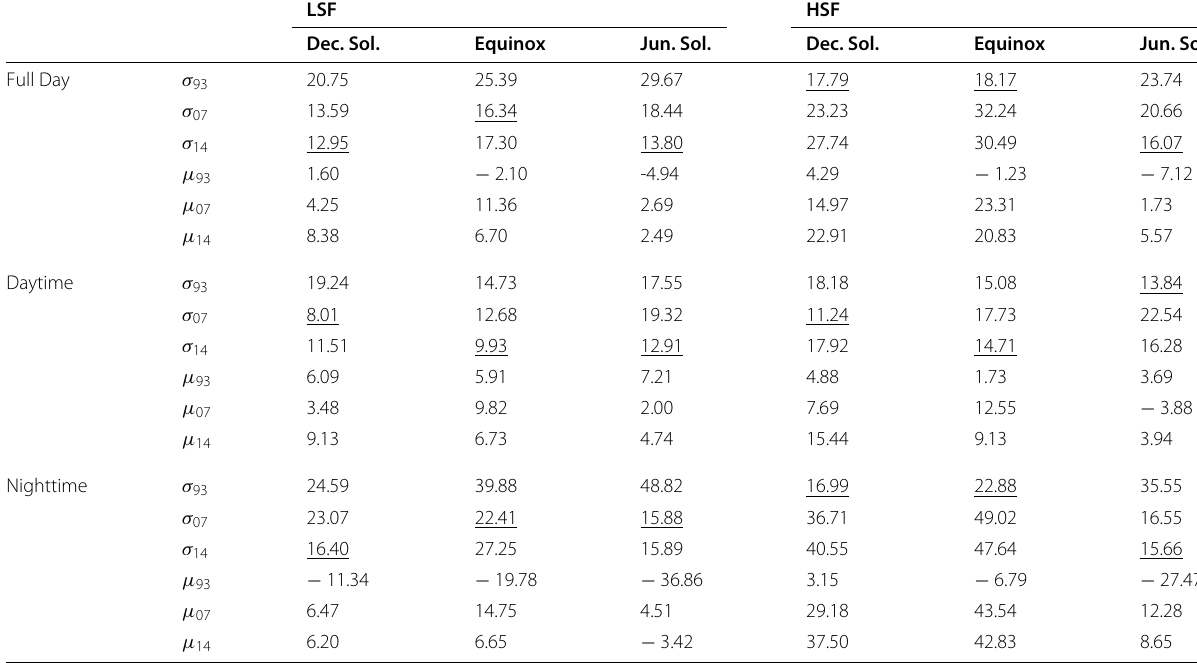
Table 1 The weighted root-mean-square error ( σ ) and weighted model bias ( μ ), where the weight is given by the inverse of the standard deviation of the climatological zonal drifts, for each model during different season and solar flux conditions LSF HSF Dec. Sol. Equinox Jun. Sol. Dec.